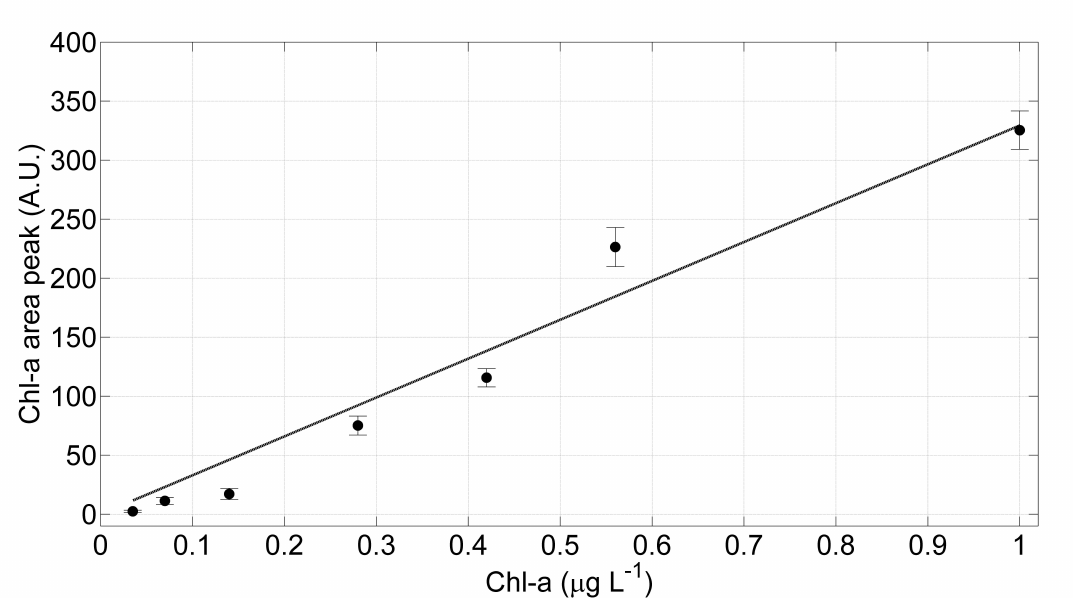
Figure 7. The LIDAR fluorosensor linearity test results. Linear regression model (grey line) has been